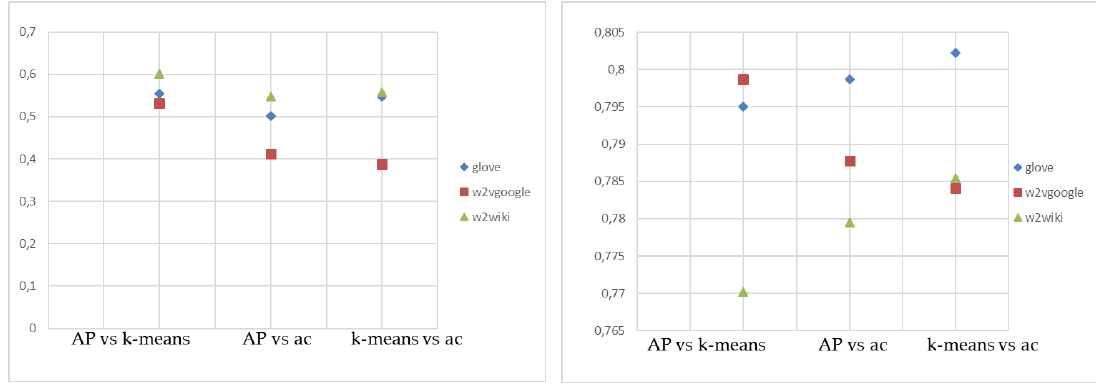
Figure 3. Comparison of clustering algorithms on 1-g (on the left) and n -grams (on the right).